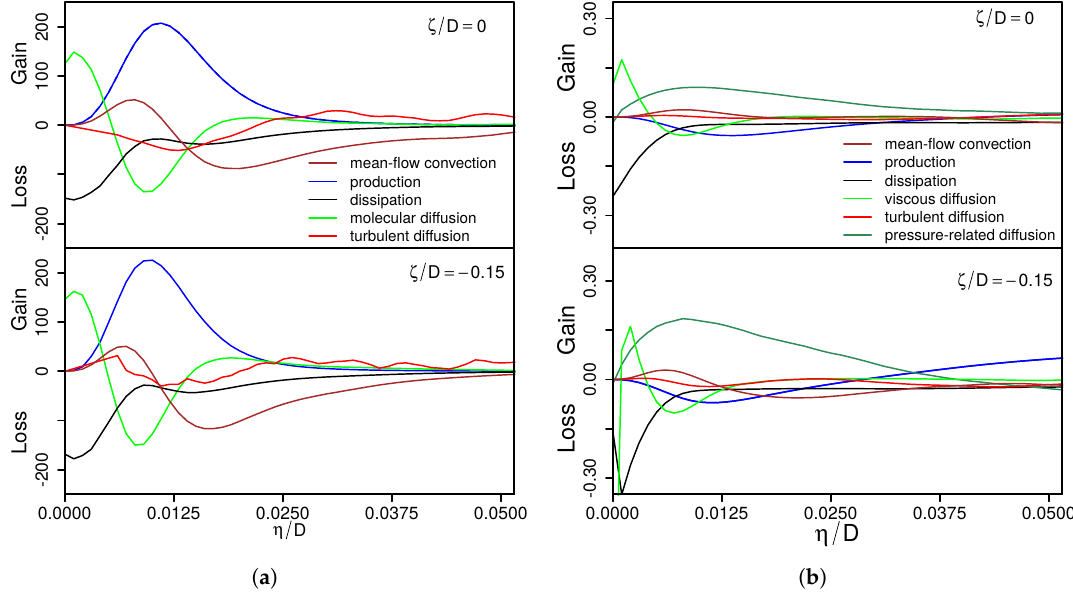
Figure 5. Normalized budget terms of T (cid:48) 2 ( a ) and k ( b ) along the wall-normal direction at ζ / D = 0 and ζ / D = −